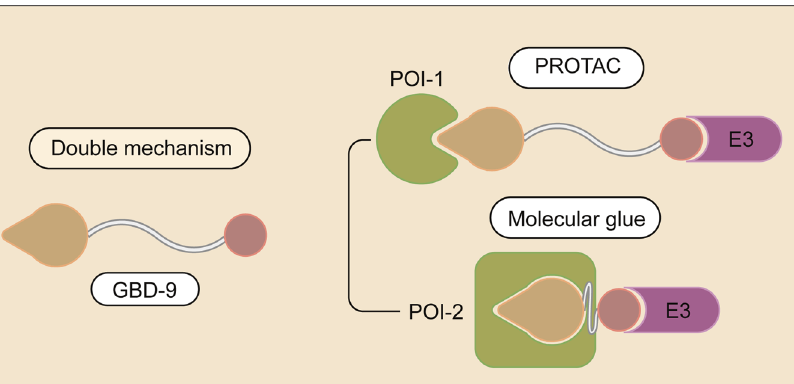
Fig. 5 Schematic representation of a double-mechanism degrader. The molecule binds to one E3 ubiquitin ligase, and can degrade two different POIs via distinct